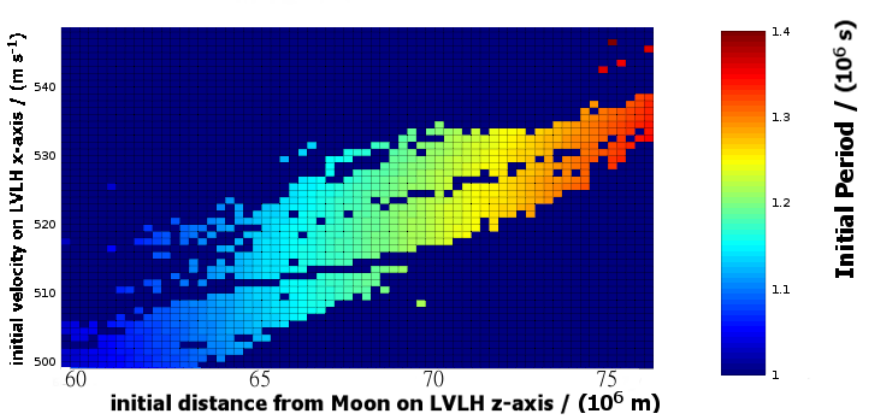
Figure 22. Detailed view of the initial orbital period, with the color axis in seconds. The data is restricted to those states for which the trajectory will be stable for 30 years.